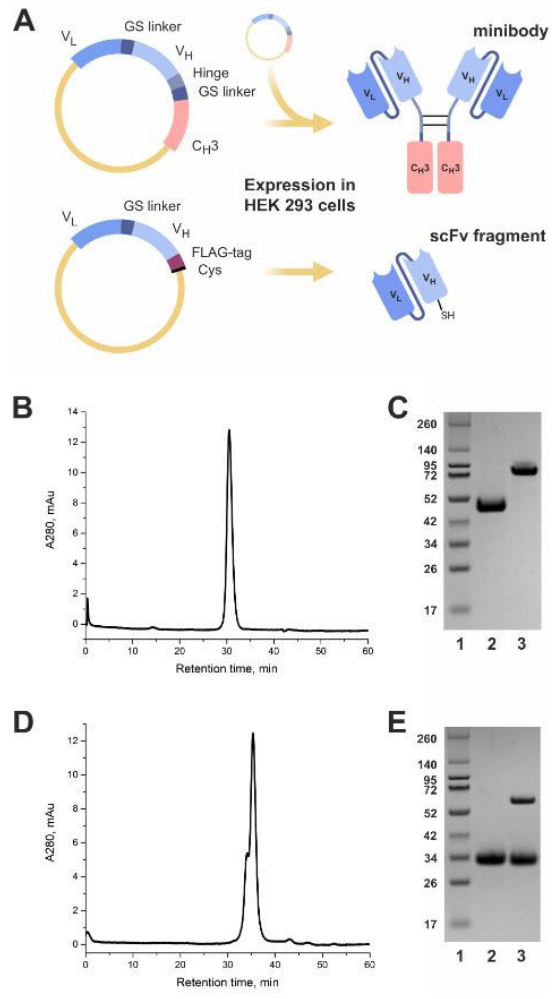
Figure 1. Design and expression of the GD2 ‐ specific antibody fragments. ( A ) Structures of the minibody 14.18 and the scFv fragment 14.18. ( B ) Size ‐ exclusion chromatographic analysis of the minibody. ( C ) Polyacrylamide gel electrophoresis of the minibody; 1, molecular weight protein markers; 2, the minibody under reducing conditions, 10 min incubation at 95 °C; 3, the minibody under non ‐ reducing conditions. ( D ) Size ‐ exclusion chromatographic analysis of the scFv. ( E ) Polyacrylamide gel electrophoresis of the scFv; 1, molecular weight protein markers; 2, the scFv under reducing conditions, 10 min incubation at 95 °C; 3, the scFv under non ‐ reducing conditions.